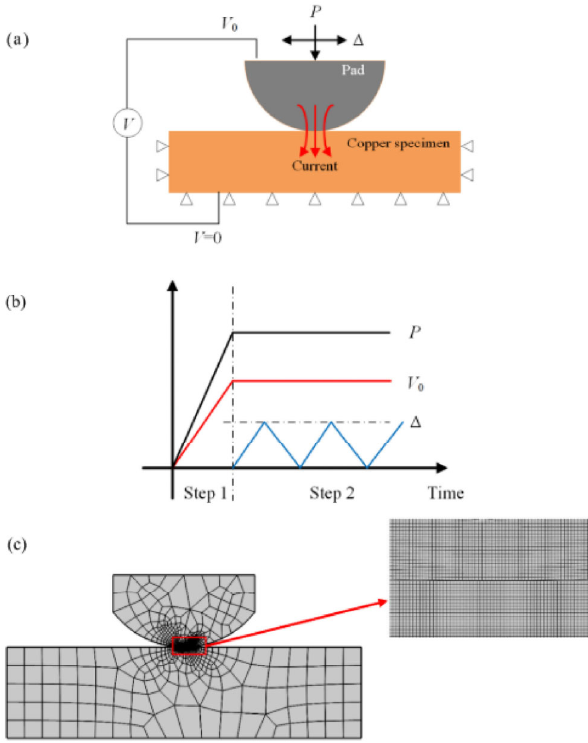
Fig. 74 (a) Schematic of electrical contact; (b) histories of applied loads; and (c) finite element mesh of electrical contact [915]. Reproduced with permission from Ref. [915], © The auther(s), 2021.